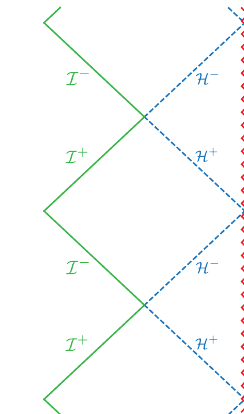
Figure 1 . The left diagram corresponds to the Penrose diagram of the exterior region of the extremal black hole in the coordinates ( (cid:27); (cid:18) ) (2.3). The Minkowski null in(cid:12)nity I (cid:6) is indicated in green, while the future and past horizon of the black hole H (cid:6) in blue. Several (cid:12)xed r trajectories are plotted in gray. The right diagram gives the maximally extended space-time, with the time-like singularity in